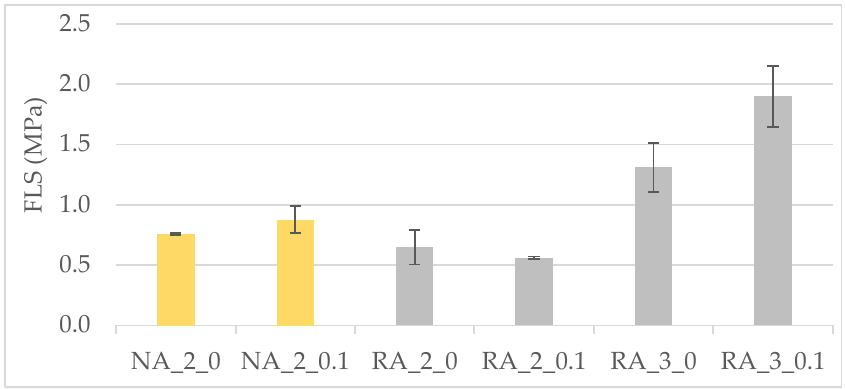
Figure 6. Flexural strength of the CBGMs at 28 days of curing.